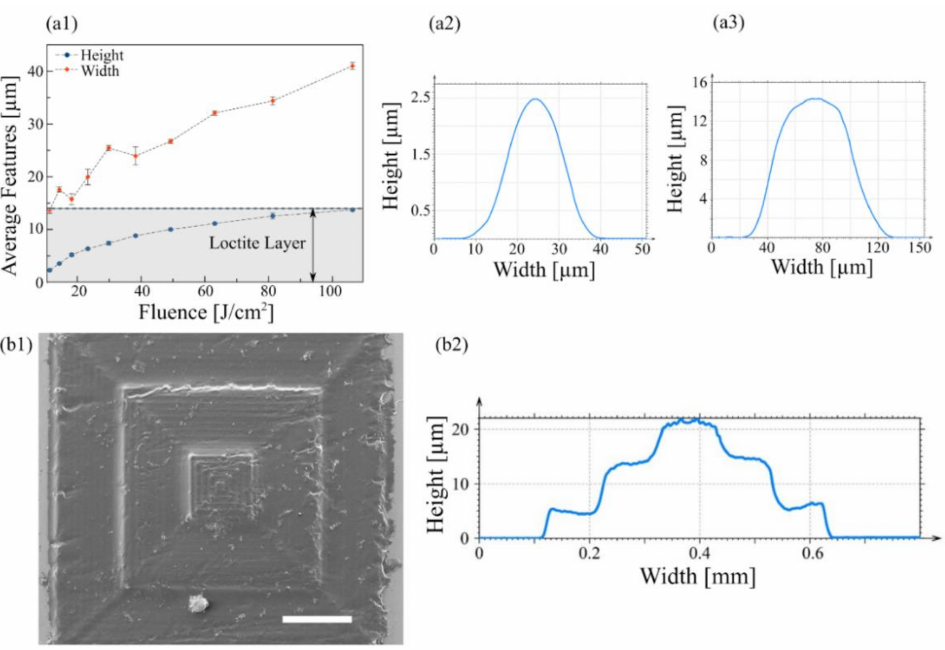
Figure 4. ( a1 ) Dimensions of crosslinked features on Loctite 3525, and profiles of the ( a2 ) smallest and ( a3 ) tallest features fabricated with 4 W/cm 2 and 106 W/cm 2 respectively. ( b1 ) SEM micrograph of a 3D pyramid fabricated on a single layer of Loctite 3525 by crosslinking the material in a Z-stepper fashion with a laser power density of 37.05 W/cm 2 ; and ( b2 ) the profile measured at the middle of the